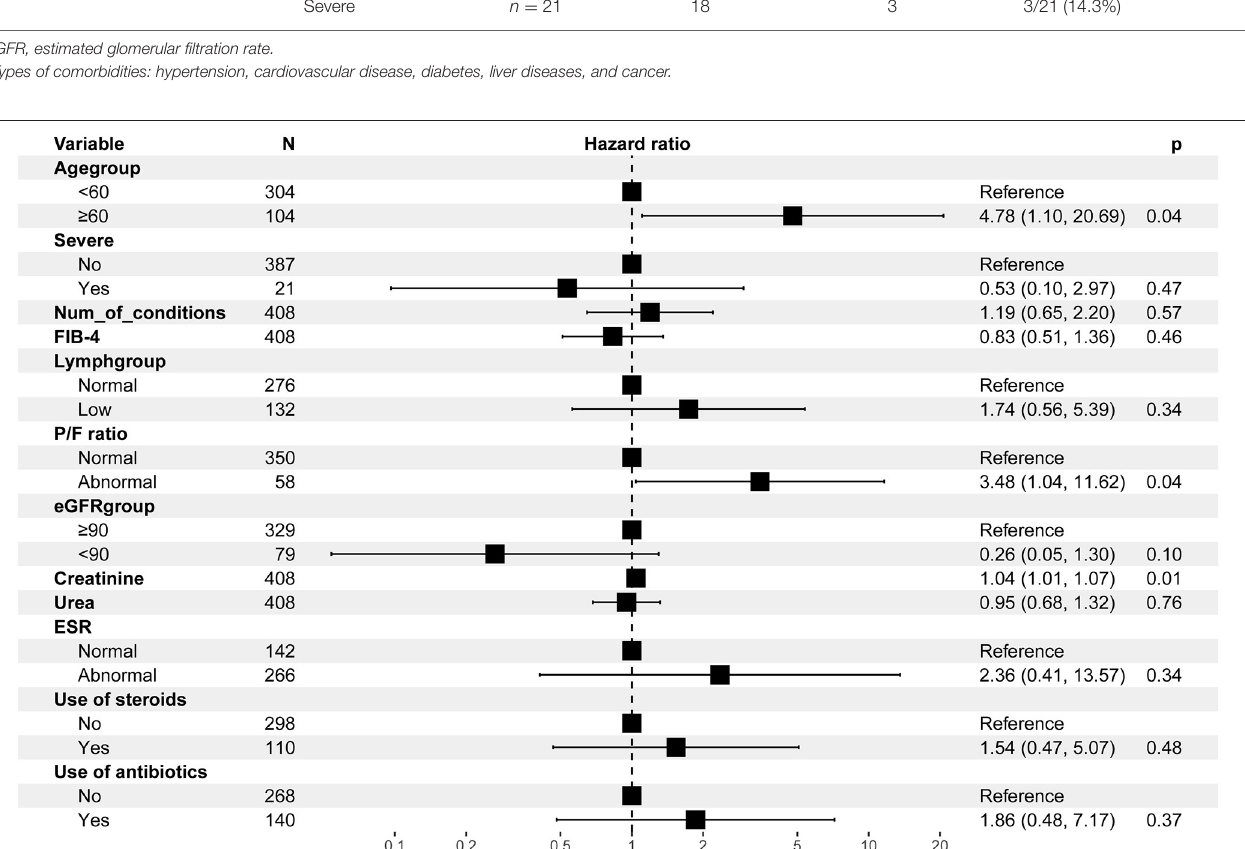
as well as the lowest eGFR during hospitalization, were